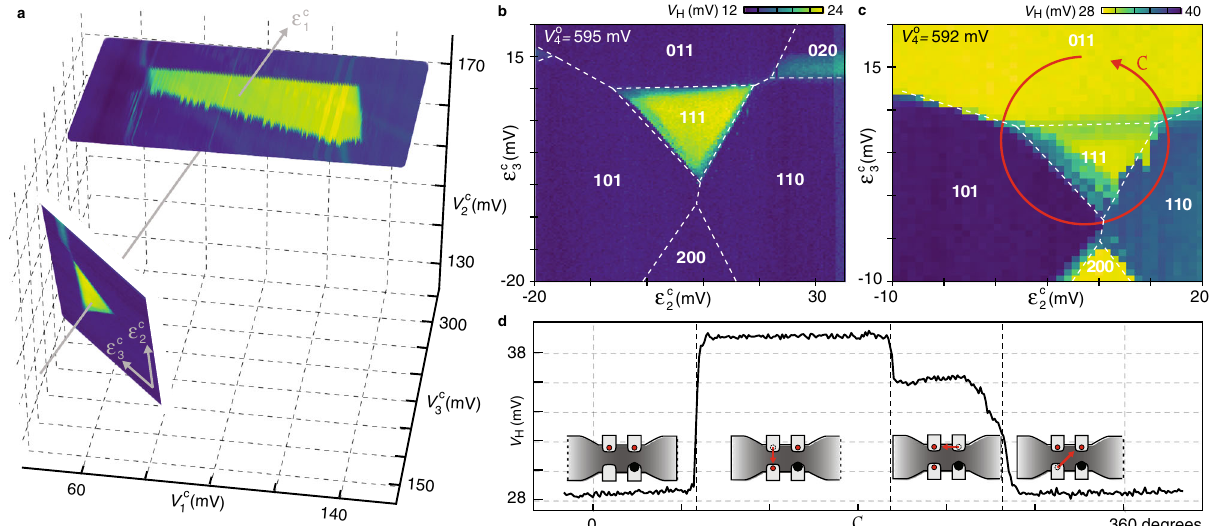
¼ constant), plotted in Fig. 4 Exchange of two electrons by permutation within a 2D array. a Ground-state region of the 111 triple dot from Fig. 2d ( V c 2 ¼ constant). Physically, ϵ c three-dimensional control-voltage space, along measurements within a plane of fi xed common-mode voltage ( ϵ c induces overall 1 1 gate charge in the array, whereas detuning ϵ c ( ϵ c ) relocates gate charge within the array along (across) the silicon channel. b Guides to the eye indicating 2 3 ¼ 595 mV, V different ground states within the detuning plane in a . For this choice of sensor operating point, V o H does not discriminate between different 4 ¼ 592 mV. The control-voltage path C two-electron con fi gurations. c Same detuning plane as in b , but with slightly different sensor operating point, V o 4 traverses three two-electron ground states in such a way that the two isolated electrons are exchanged within the array. d Sensor signal V H acquired during one cycle of the shuttling path C. Changes in V H re fl ect single-electron movements within the array, as illustrated by red arrows. After completion of one cycle C, the position of the two electrons in the array has been